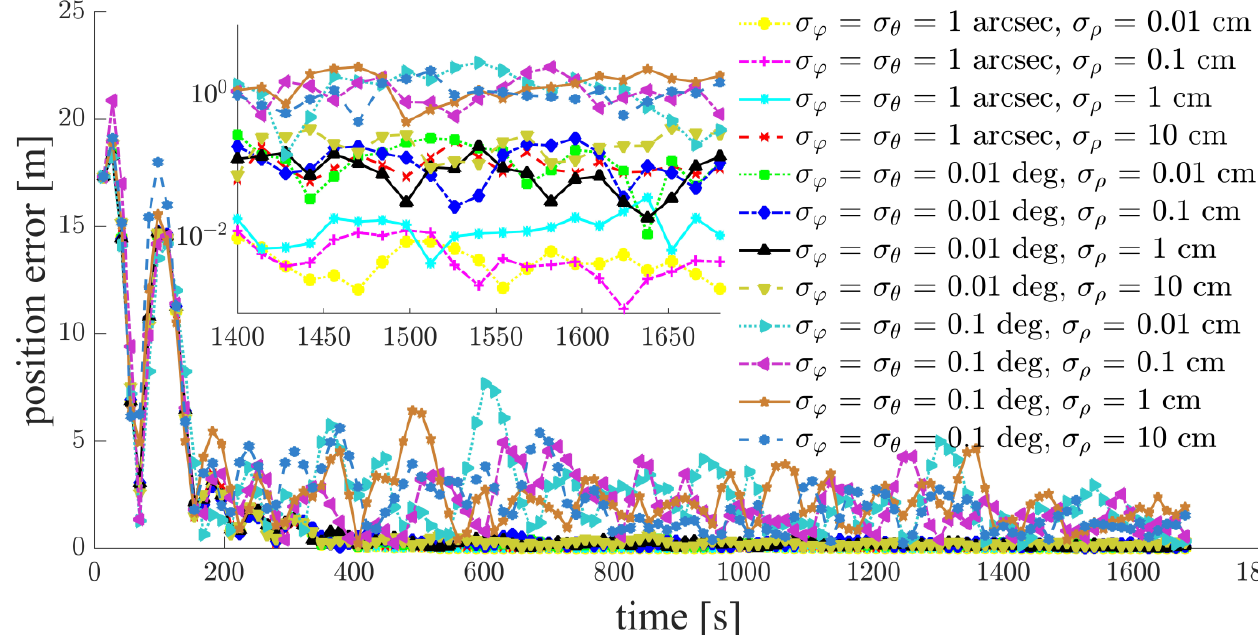
Figure 13. Relative navigation errors of 𝑆 3 (simulated scenario: Case d, space-circle formation radius of 1 km).